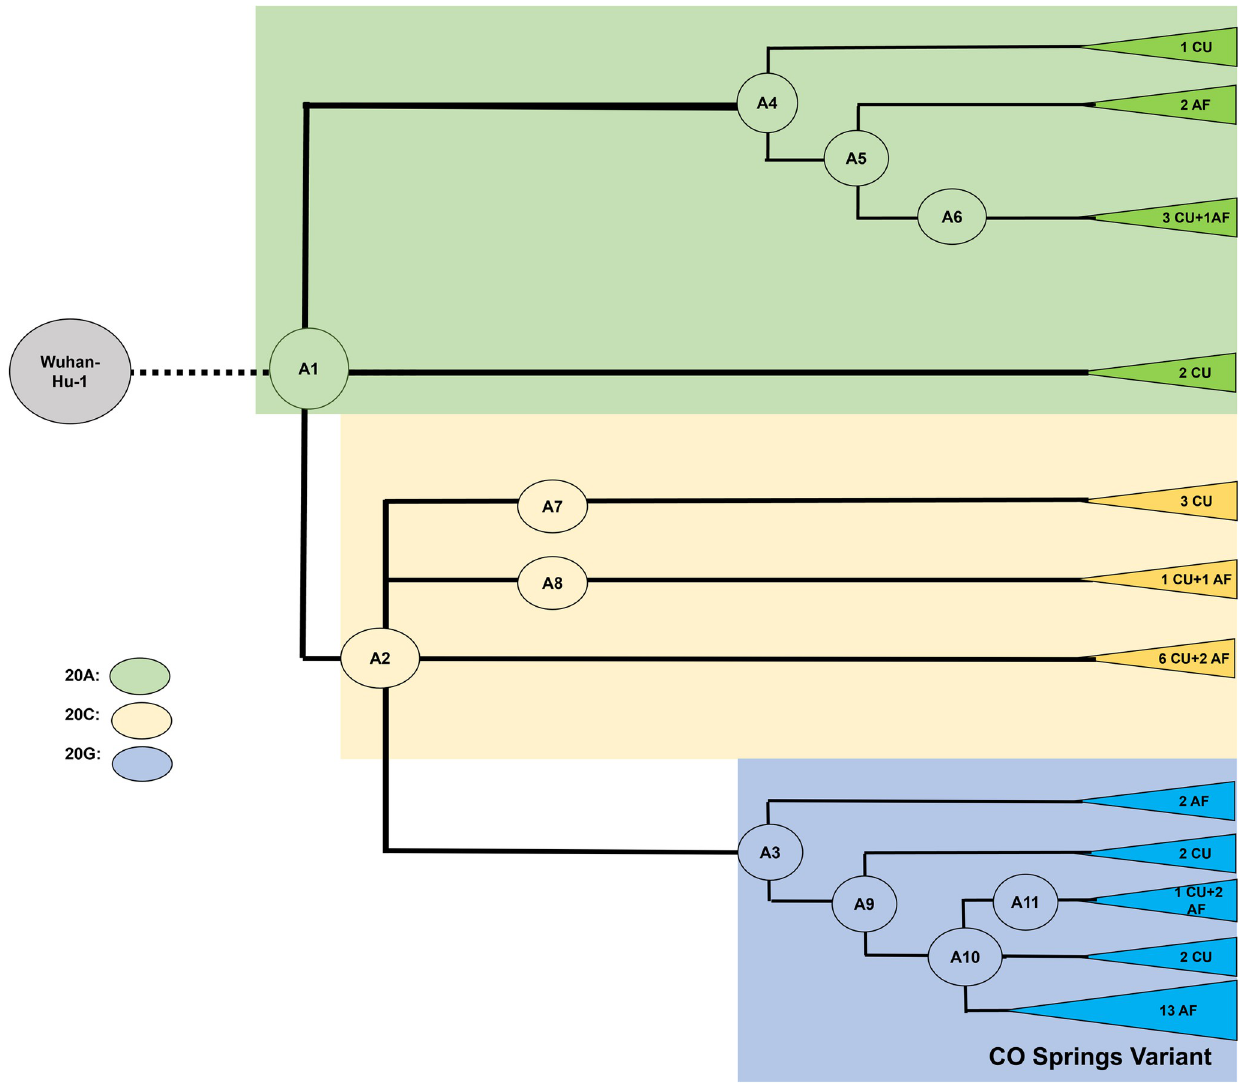
Fig 2. Major phylogroup clustering of the CUAF SARS-CoV-2 genomes. Tip labels indicate how many CU Anschutz (CU) and USAFA (AF) genomes are associated with ancestor. Color shading indicates which main phylogroup genomes belong to, A1-A3, corresponding to NextStrain clades 20A, 20C and 20G,